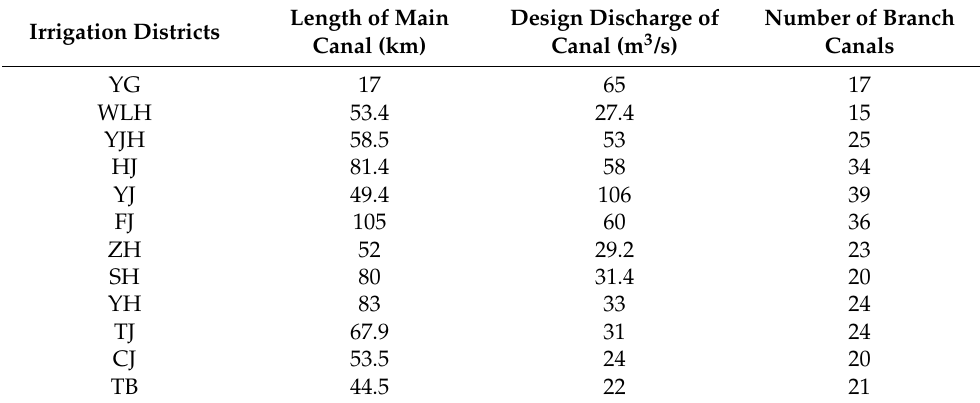
Table 2. Canal system data of Hetao Irrigation District.